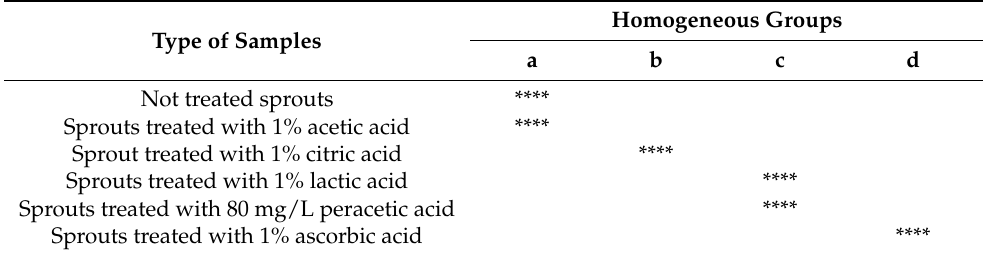
Table 5. Group homogeneity test ( α = 0.05) comparing the effect of the organic acids used on the antioxidant properties (ABTS) of red cabbage sprouts subjected to 7-day storage.